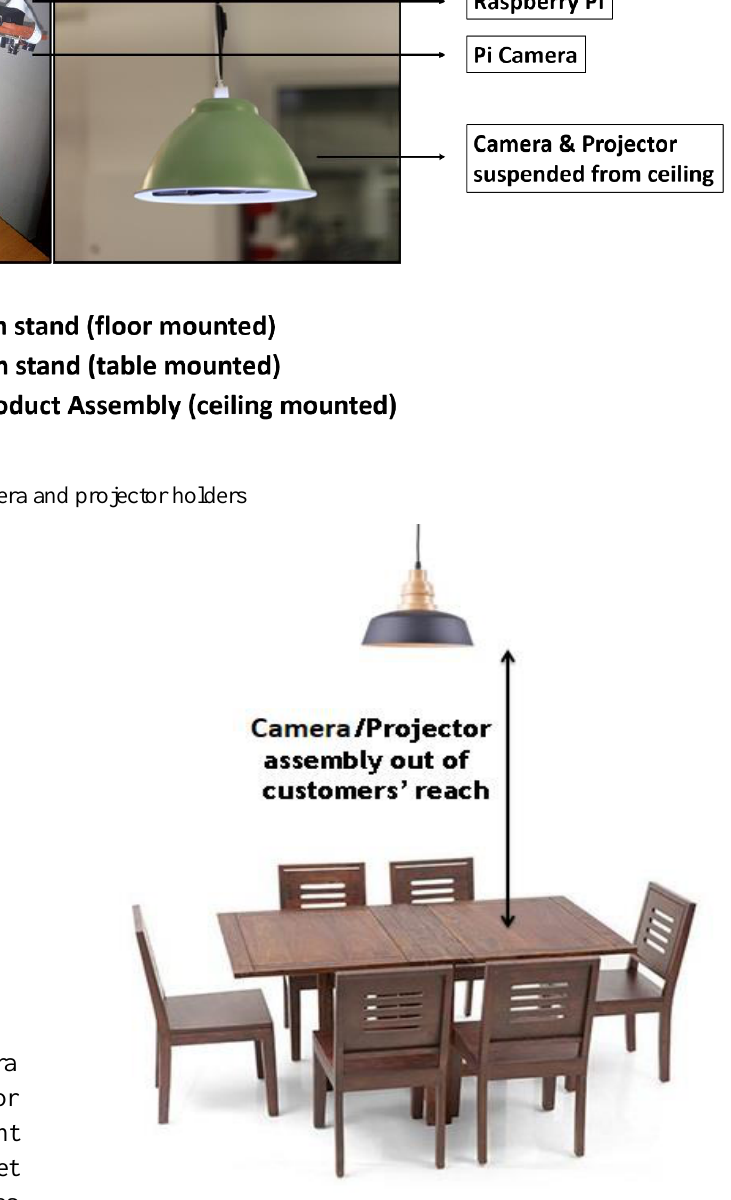
Fig. 5. Equipment away from physical